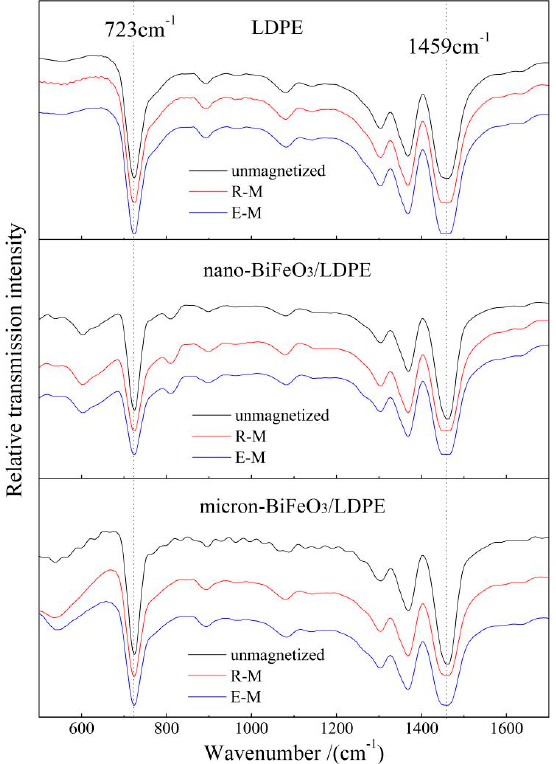
Figure 2. Fourier transform infrared (FTIR) spectra of low-density polyethylene (LDPE) (upper panel), 2 wt % nano-BiFeO 3 /LDPE composite (middle panel) and 2 wt % micron-BiFeO 3 /LDPE composite (bottom panel) after magnetization room (R-M) and elevated (E-M) temperatures.